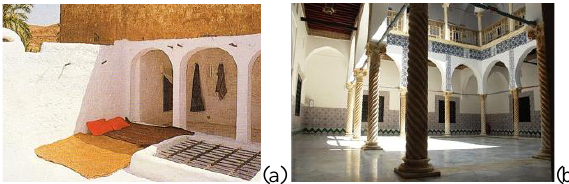
Figure 7. (a) A shaded Ikomar in a house of the M’zab valley (Ravéreau, 2003); (b) A shaded gallery in a house of the Kasbah of Algiers 34